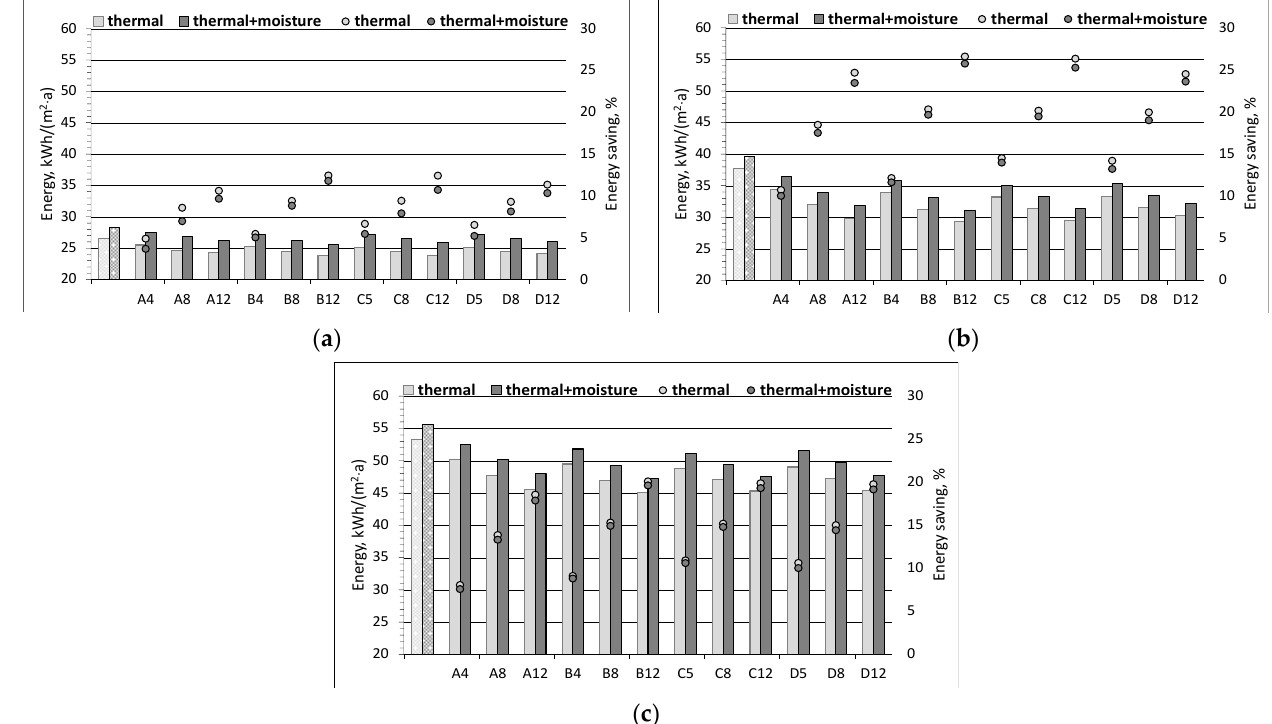
Figure 3. The individual usage of energy for heating and ventilation purposes for the analyzed types and thicknesses of internal thermo-insulation for Warsaw and external insulation made of MW, ( a ) one external wall, ( b ) two external walls, ( c ) three external walls.